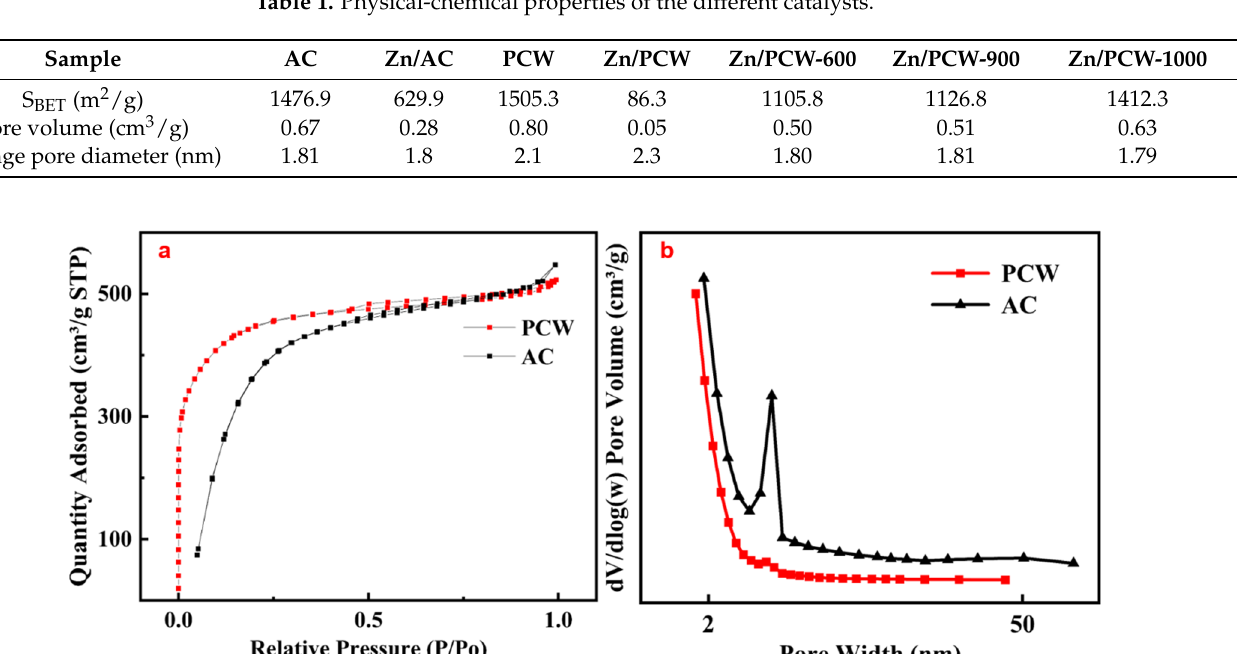
Table 1. Physical ‐ chemical properties of the different catalysts.